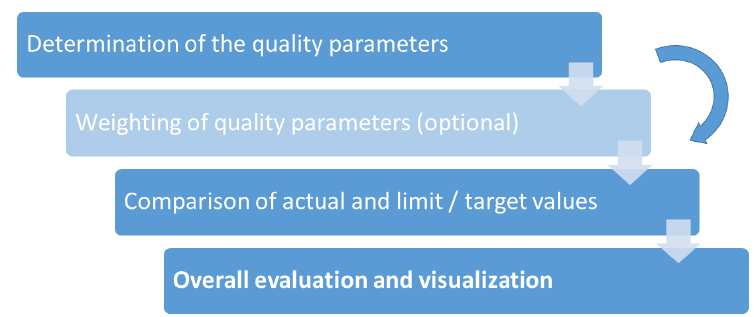
Figure 10. Evaluation of the suitability of a point cloud with the quality